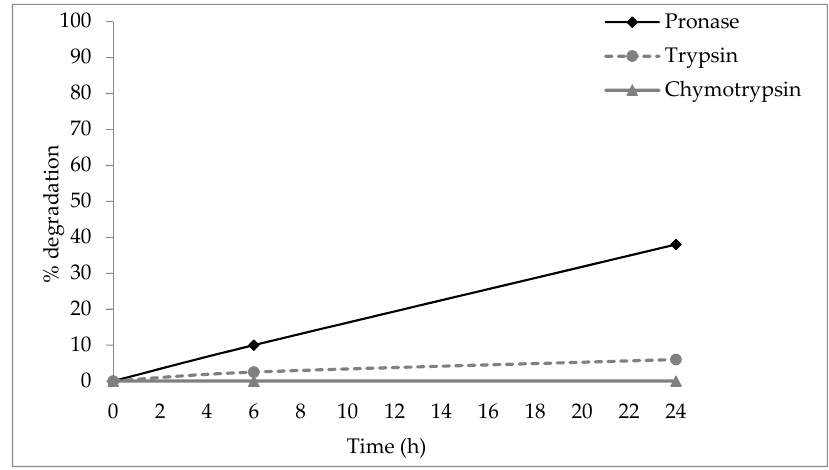
Figure 3. Proteolytic degradation of peptide-peptoid hybrid B1 by chymotrypsin, trypsin, and pronase.